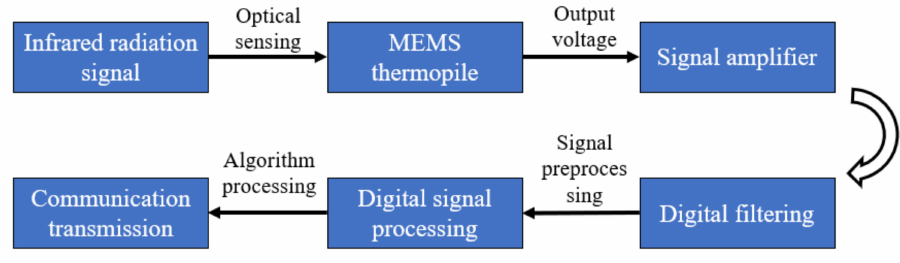
Figure 9. Schematic diagram of infrared temperature sensor.